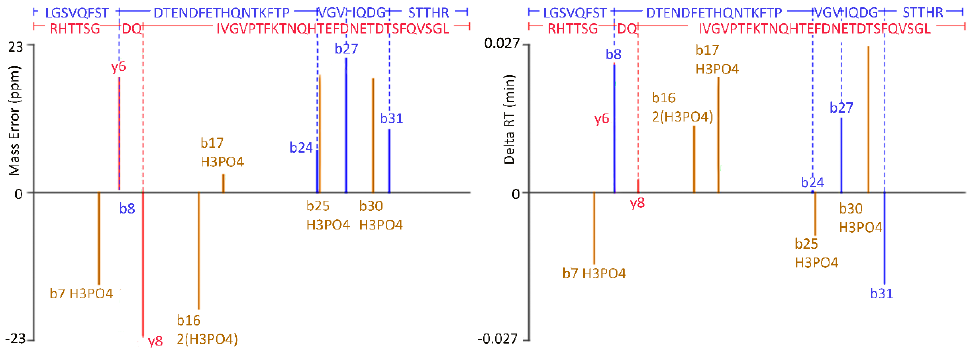
Figure 3. Representative figure of protein phosphorylation. Twenty phosphorylation sites were found. The above figure was 393T and 394T phosphorylation on peptide LGSVQFSTDTEND-FETHQNTKFTPVGVIQDGSTTHR. The peptide sequences and annotated fragment ions were shown in blue (from N-terminal to C-terminal), red (reversed), and brown (phosphorylated). The mass error of the fragment ions was between ± 23 parts per million (ppm), comparing the theoretical m/ z with the experimentally observed m/ z . The Delta retention time (RT) was within ± 0.027, reflecting fine reproducibility.